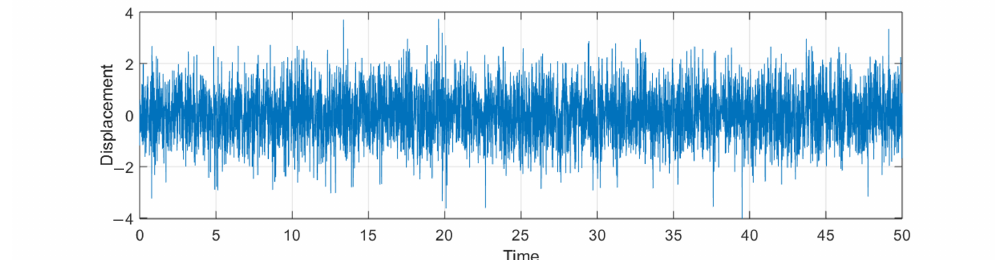
Figure 13. The time history of the random excitation.